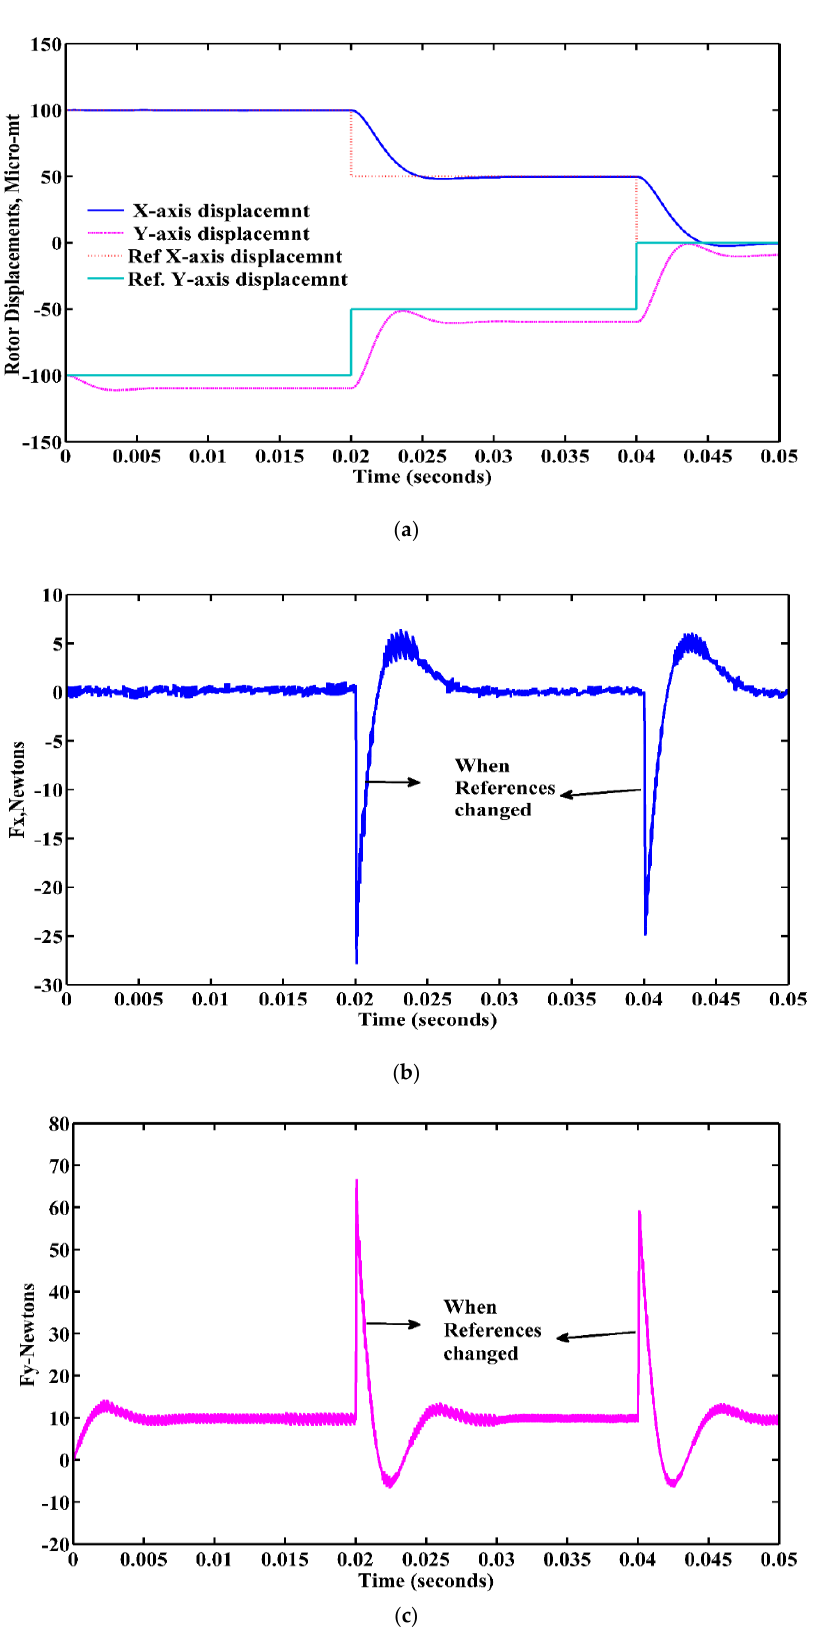
Figure 19. Second Quadrant supension parameters. ( a ) Rotor Xand Y-axis dispalcements when references are changed; ( b )Suspension force in the X direction; ( c ) Suspension force in the Y direction.